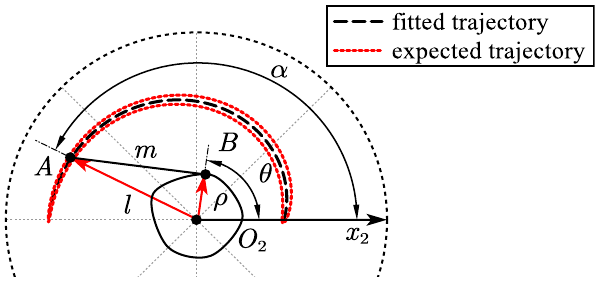
Figure 3. The expected and fitted trajectory of 𝐴 in 𝑂 𝑟 𝑥 𝑟 PCS with one rotation of the crank. When the string is free of deformation and slack, Equation (3) should be satisfied,